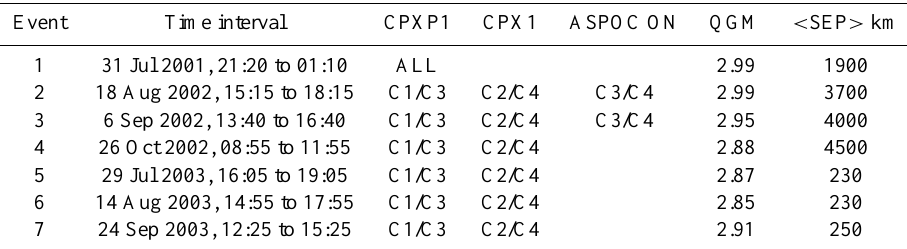
Table 1. Time intervals included in study. Event Time interval CPXP1 CPX1 ASPOC ON QGM < SEP >